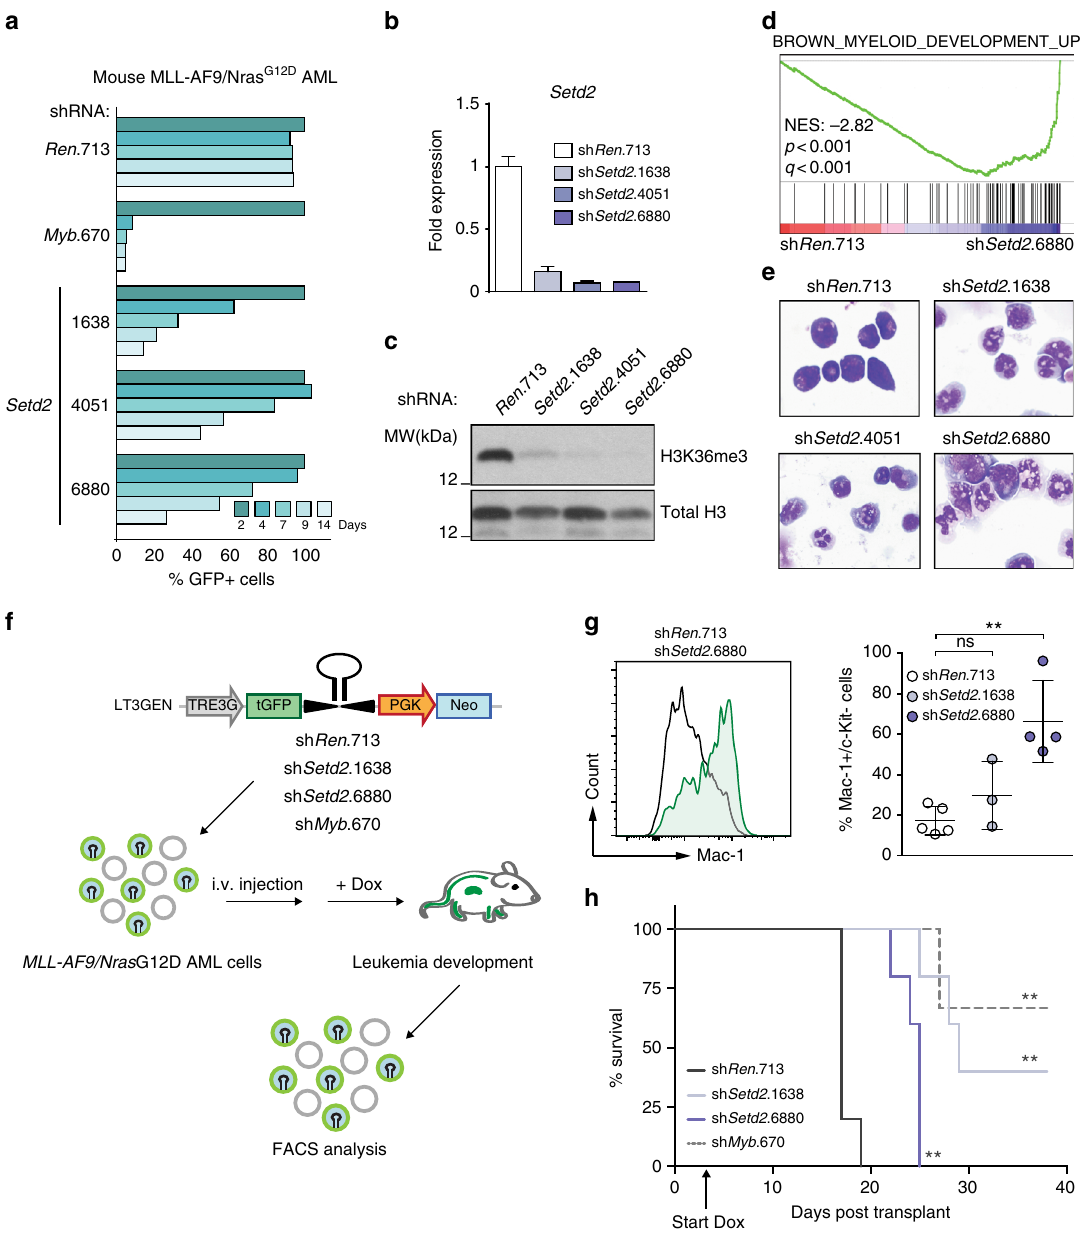
Fig. 5 SETD2 loss induces myeloid differentiation of MLL-leukemia cells. a Results of competitive proliferation assay shown as the percentage of GFP- positive mouse MLL-AF9/Nras G12D AML cells expressing indicated shRNAs in the presence of Dox over 14 days. One representative experiment out of three is shown. b qPCR analysis of Setd2 mRNA levels in MLL-AF9/Nras G12D cells expressing indicated shRNAs after 48 h of Dox treatment (mean ± s.d. n